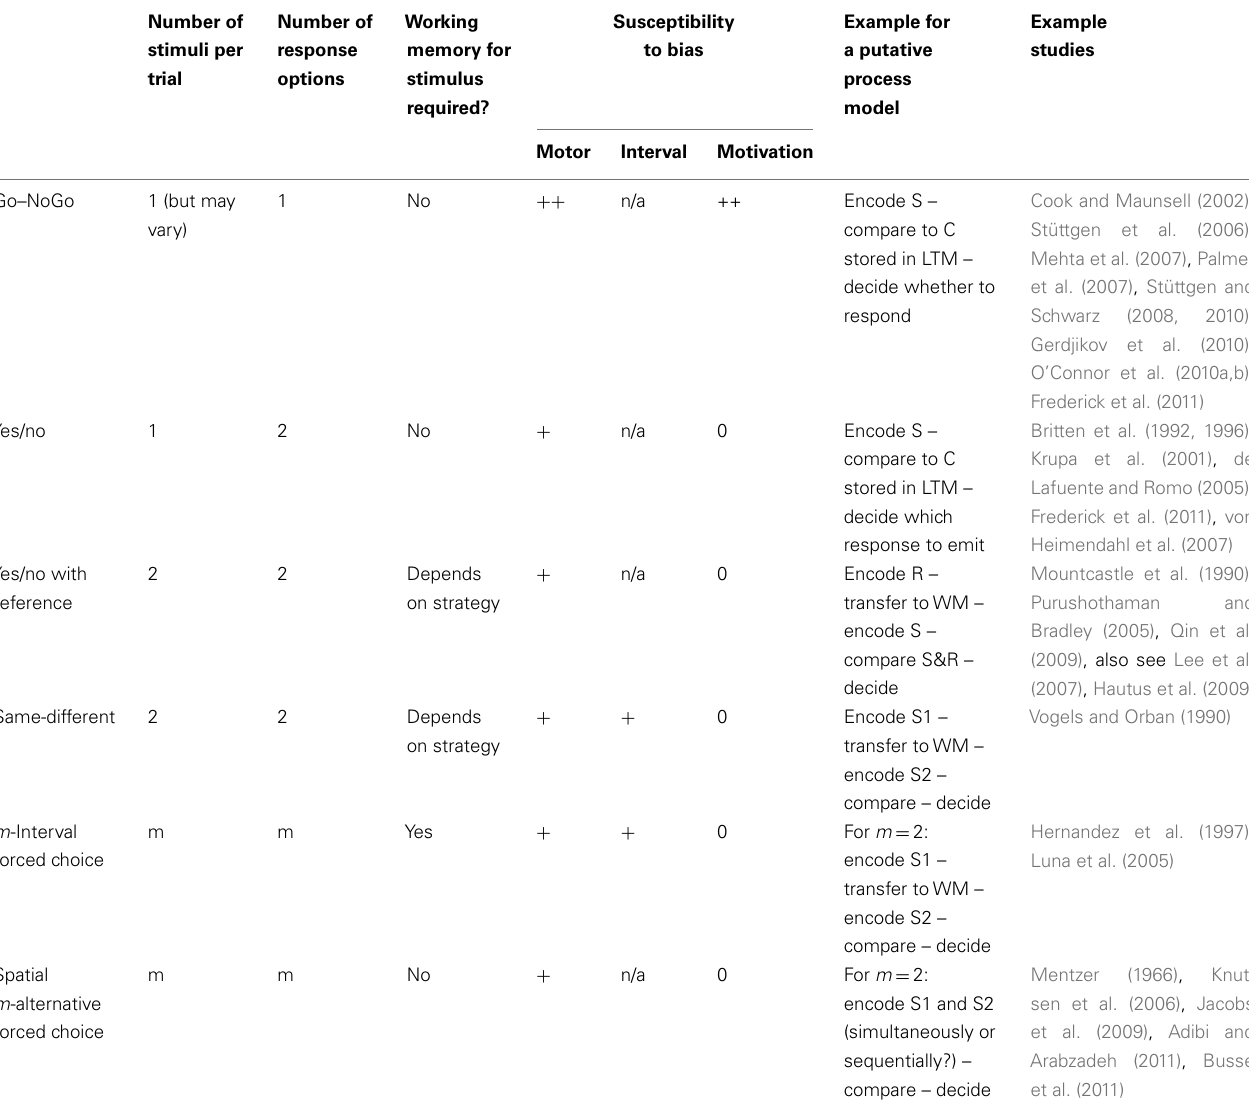
Table 1 | Overview over the most frequently used tasks in animal psychophysics and their